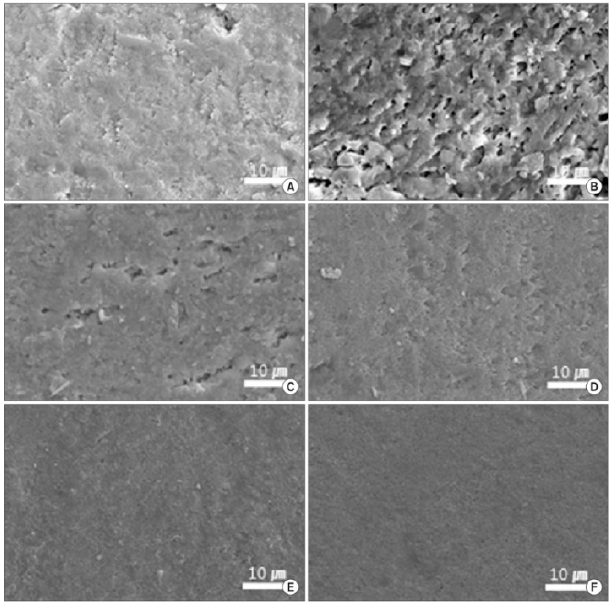
Figure 5. Scanning electron microscopy (SEM) micrographs of enamel surface treated with ( A ): control; ( B ): bleaching with 10% carbamide peroxide; ( C – F ): whitening treatment with different mixtures of HA, ACP, and tetrasodium pyrophosphate (TSP); ( C ): ACP 0.3%, HA 0.2%, and TSP 0.1%; ( D ): ACP 0.75%, HA 0.5%, and TSP 0.25%; ( E ): ACP 1.5%, HA 1.0%, and TSP 0.5%; ( F ): ACP 3.0%, HA 2.0%, and TSP 1.0%. (Reprinted from [115].)